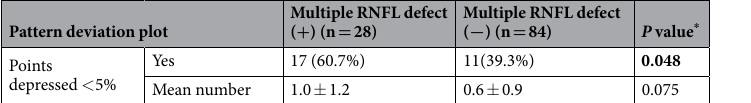
Table 3. Paracentral visual field points depressed < 5% on pattern deviation plot. * Statistically significant differences between two groups ( P < 0.05) by Student’s t-test for continuous variables or chi-squared test for categorical data are indicated in bold.